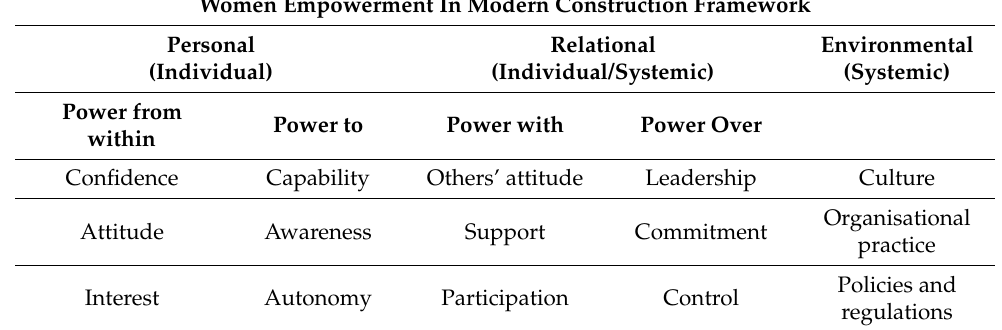
Table 1. Women’s empowerment framework, adapted from Oxfam